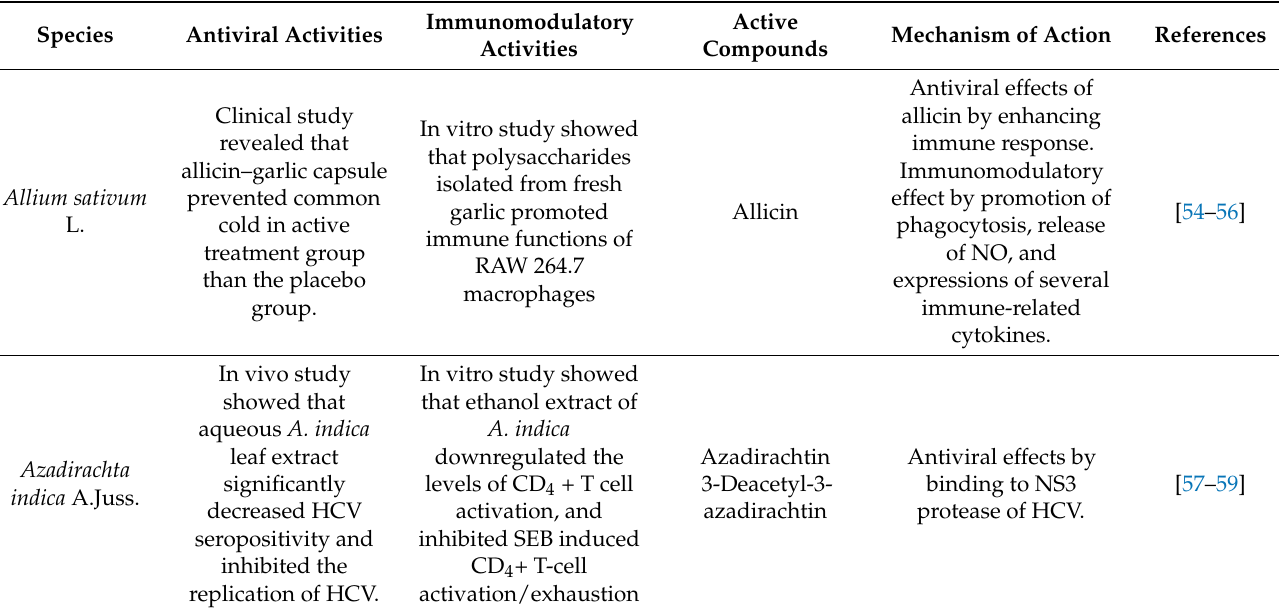
Table 5. Antiviral and immunomodulatory properties of top-cited species used for the treatment of COVID-19, cough, and